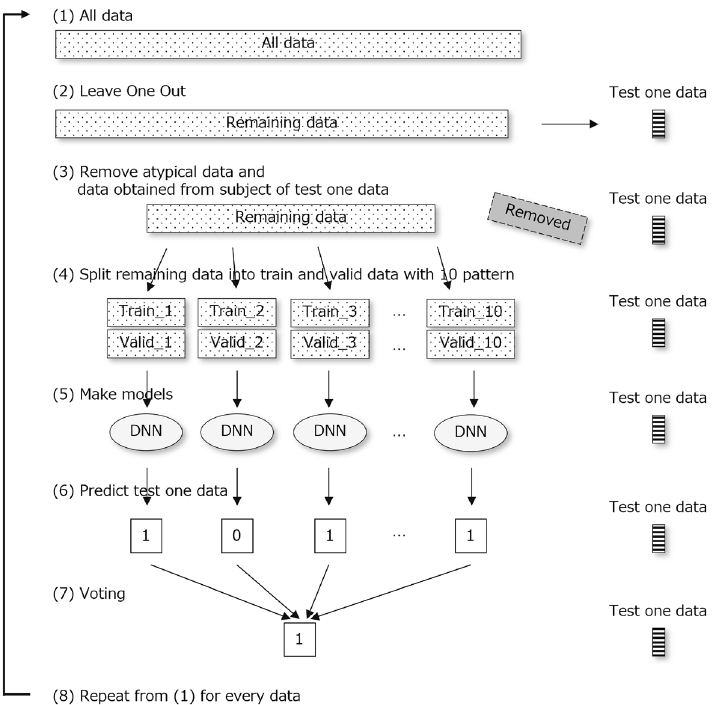
Figure 4. Architecture of the machine learning and validation